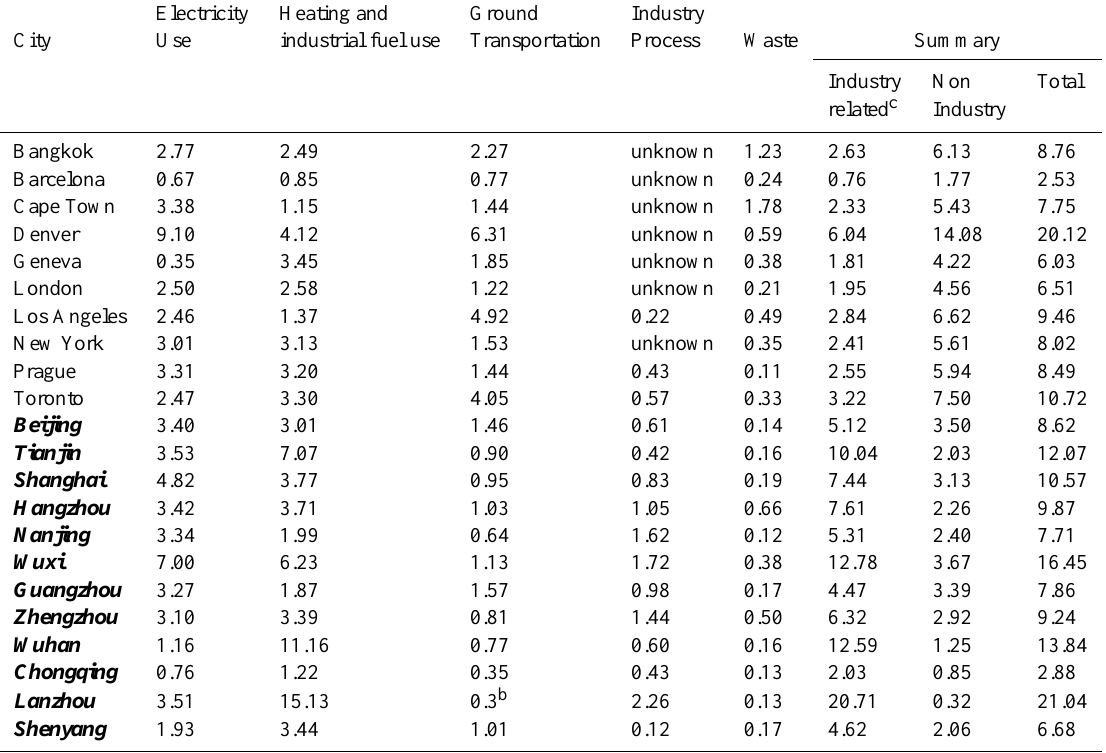
Table 2. Summary of the Per Capita Carbon Emissions from 12 Chinese Cities in 2005 and other Ten Cities in the World (t-CO 2e /capita) a . Electricity Heating and Ground Industry City Use industrial fuel use Transportation Process Waste Summary